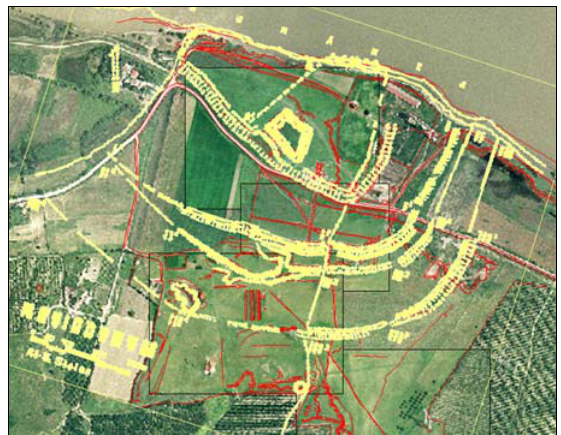
Figure 4. Overlapping of an ortophotoplan with the main landmarks of the site (red) and the Al. Ş tefan fortifications plan (yellow), both stone and